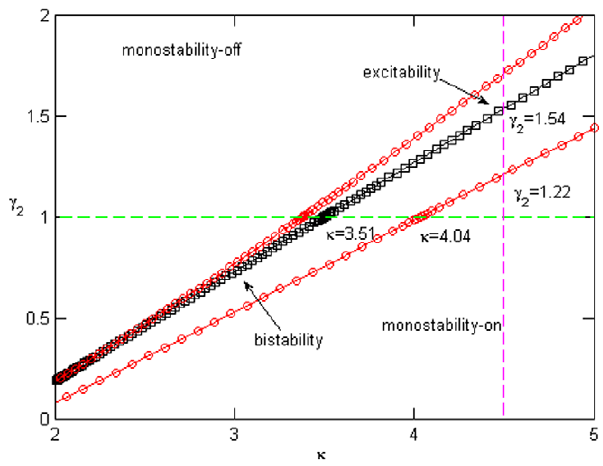
Figure 3. The bifurcation diagram spanned by the positive feedback ( k ) and the miRNAs inhibition ( c 2 ). The red circles and black squares on borderlines represent saddle-nodes and Hopf bifurcations, respectively. The diagram includes three features: mono- stability, bistability, and excitability. The green and plum dashed lines denote the cases in which c 2 ~ 1 : 0 and k ~ 4 : 5 , respectively. The parameter values are a ~ 0 : 15 , c 1 ~ 1 : 0 , and e ~ 0 : 05 .